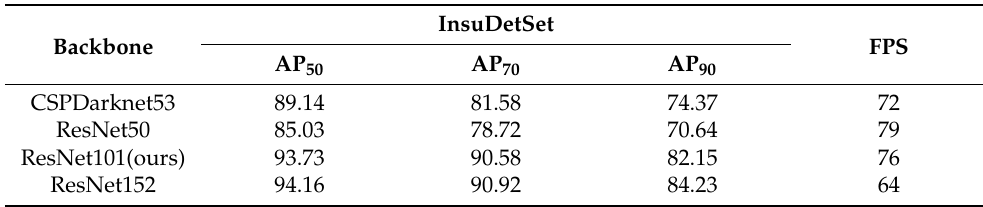
Table 5. APs of different backbones.